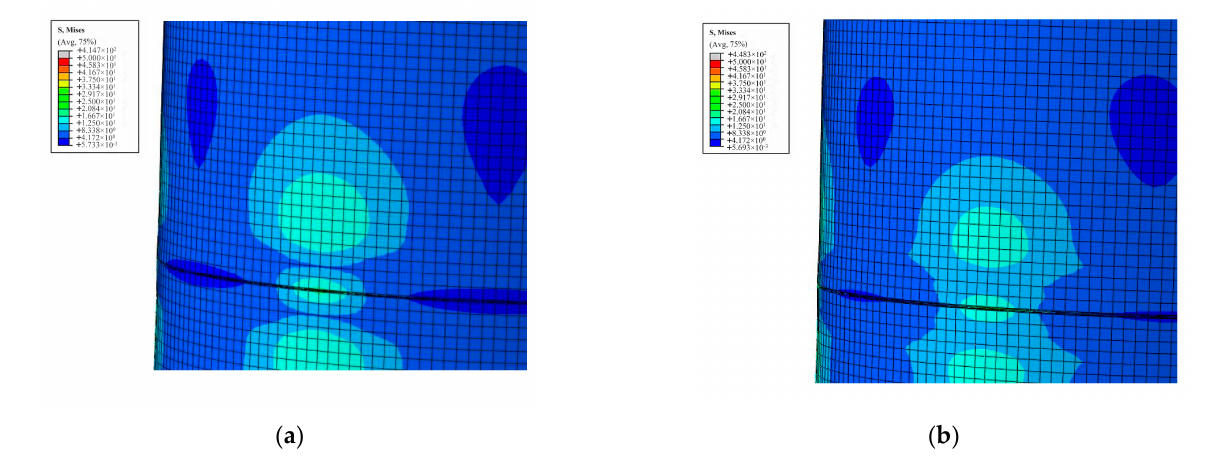
Figure 11. Comparison of stress clouds near fastening bolt and loosening bolts under static load; ( a ) No loosening; ( b ) One bolt loosened to 0.3 kN.